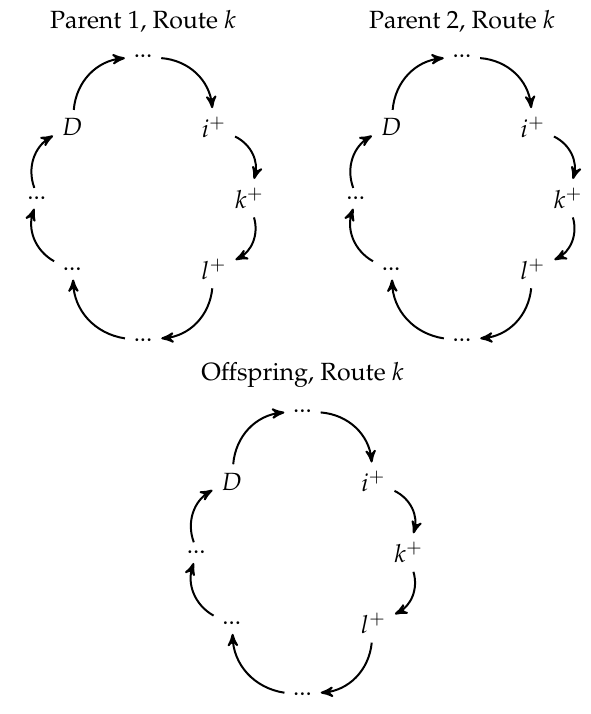
Figure 7. Two parents’